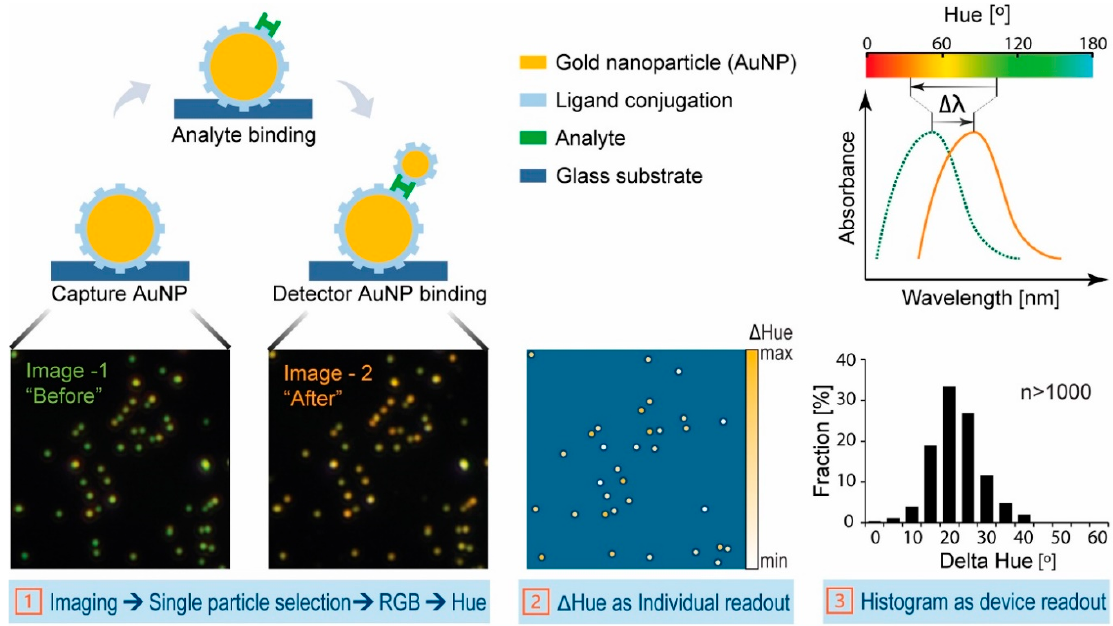
Figure 15. Schematic of the sensing platform using a swarm of single nanoparticle colorimetric sensors. Reprinted [147], Copyright 2019, with permission from Elsevier.